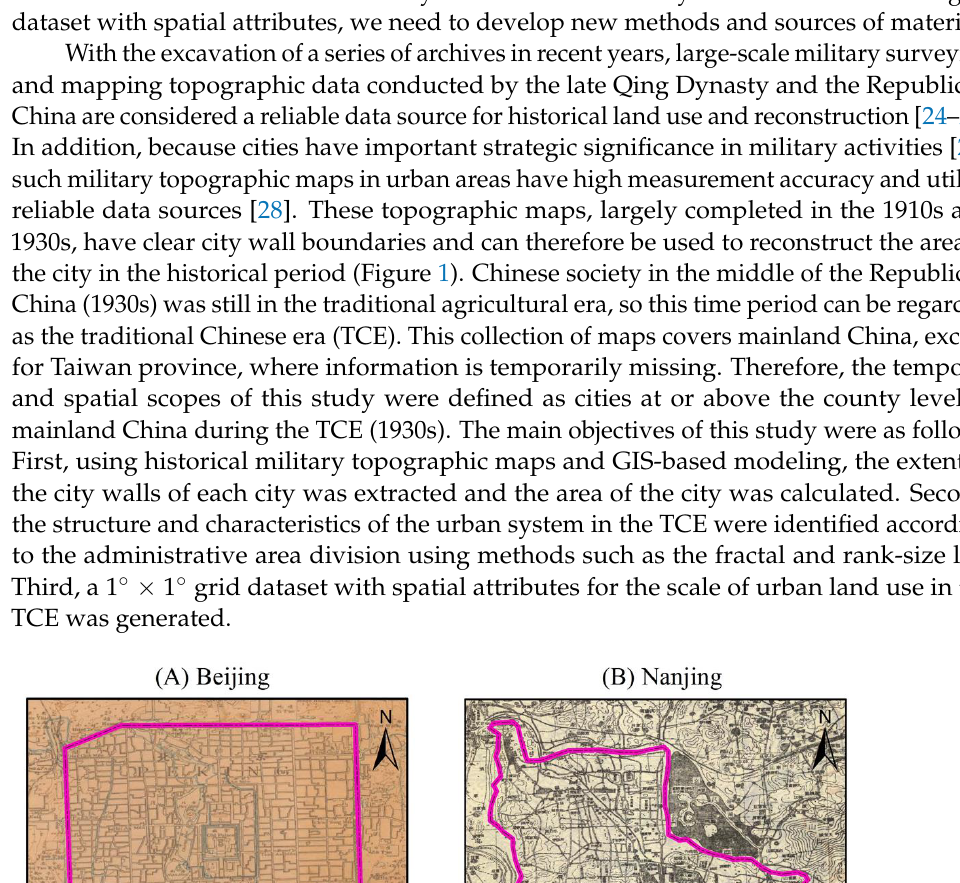
Figure 1. Example of the urban scope marks in the military topography of the Republic of China ( A − F represent Beijing, Nanjing, Suzhou, Kaifeng, Xian, and Guangzhou, respectively). 2. Research Area, Data, and Methods 2.1. Definition of the Scope of the Research Area Considering the possibility of obtaining data and facilitating comparative study, land use reconstruction in historical periods is still based on the modern administrative scope [29,30]. The Chinese Modern Administrative Region can be roughly divided into regions such as the Central Plains, the southwest, South China, Jiangnan, the northwest, and